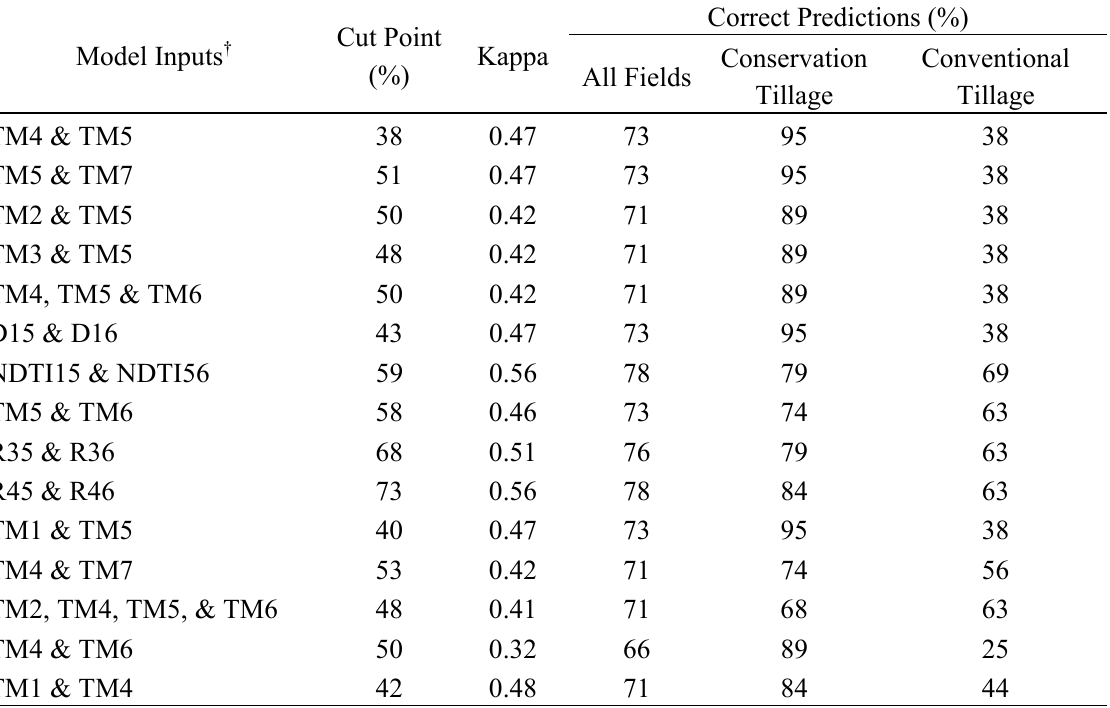
Table 5. Validation performance of Landsat 5 TM based ANN models used for mapping tillage practices in Ochiltree County, Texas using Method-II (Cutoff probabilities values associated with maximum percent correct in the validation